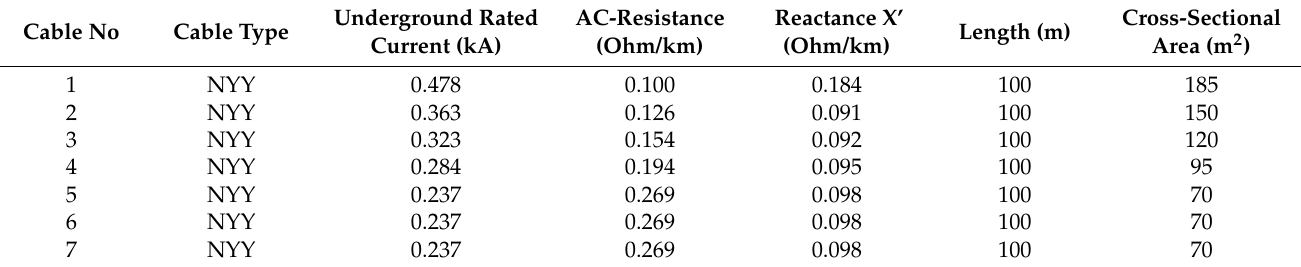
Table 6. Cable characteristics for network 4.